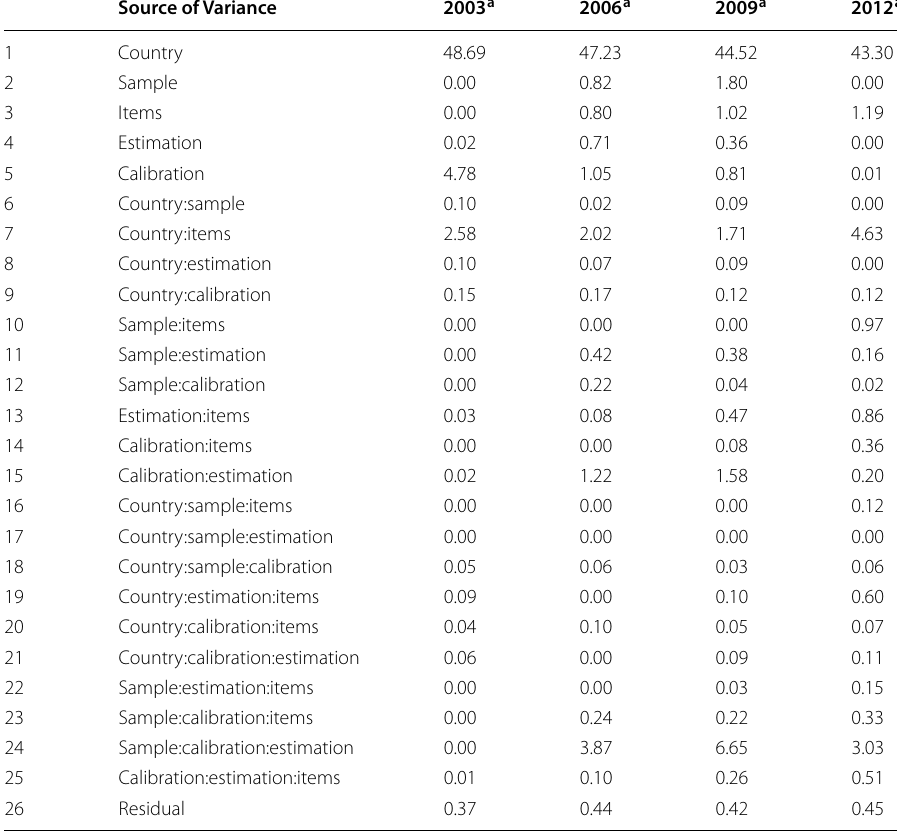
Table 5 Standard Deviations of Different Factors of Analytical Decisions for Cross‑Sectional Country Means in PISA Mathematics Obtained from a Variance Component Analysis